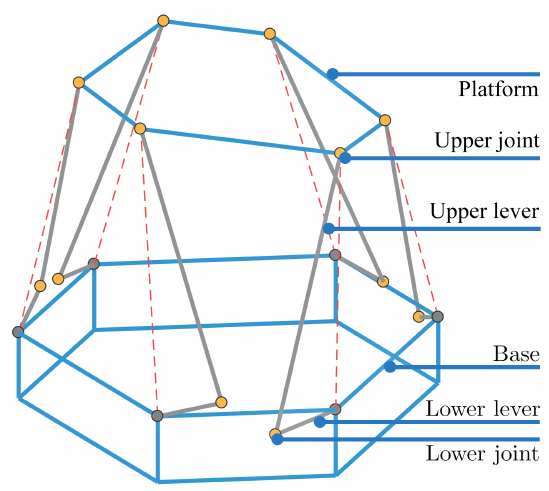
Figure 2. Stewart platform with rotary